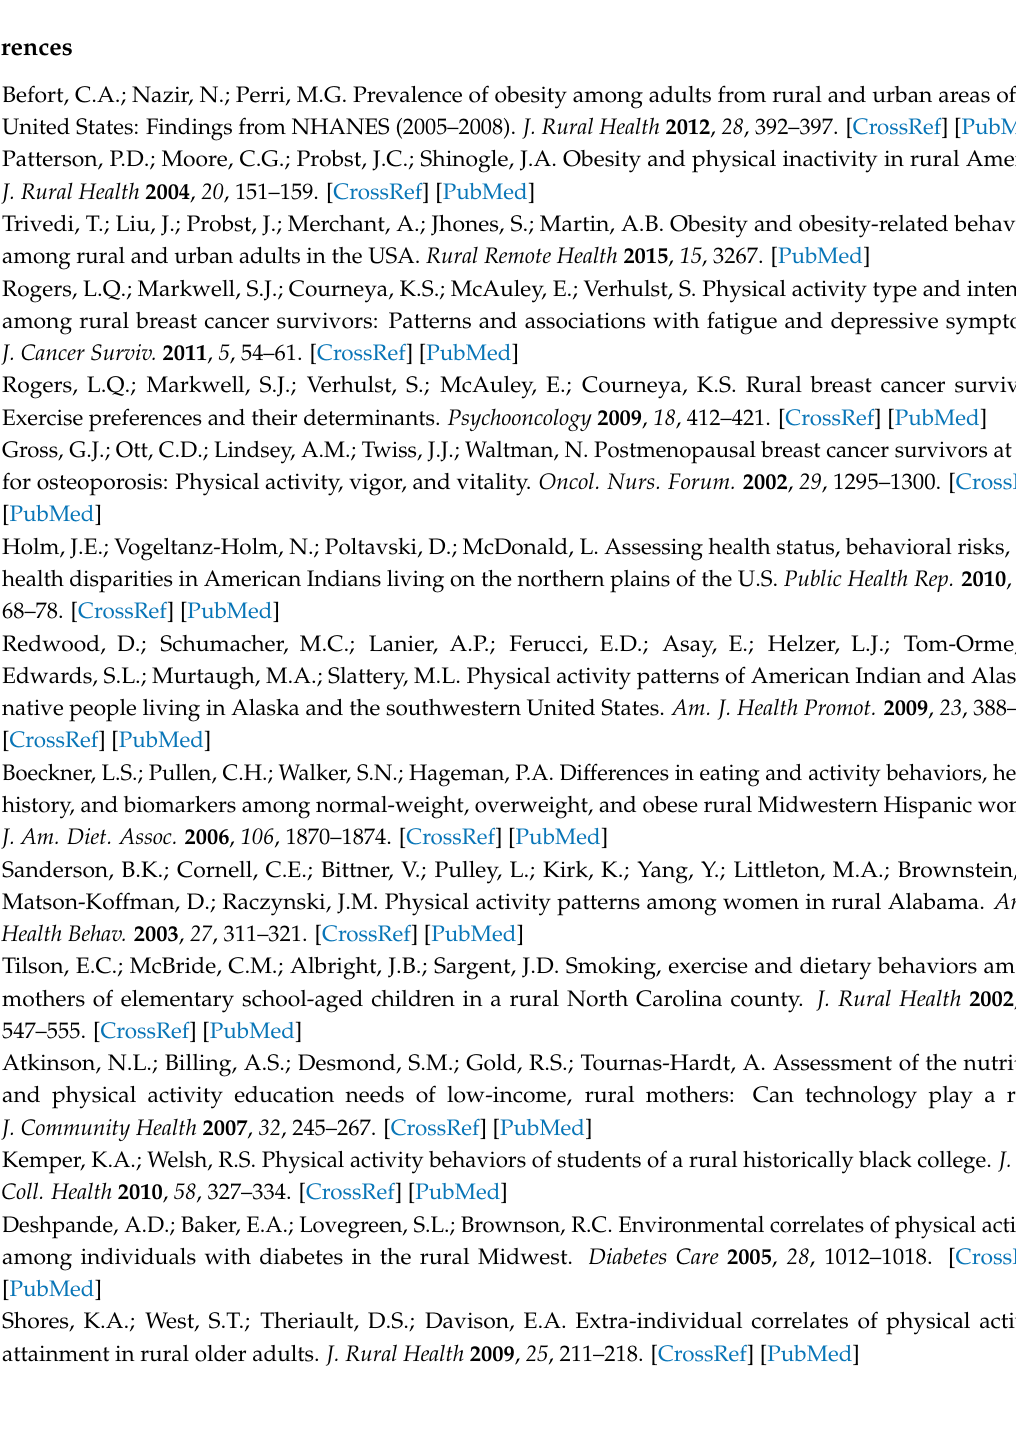
s1: Table S1: Changes made to food categories for